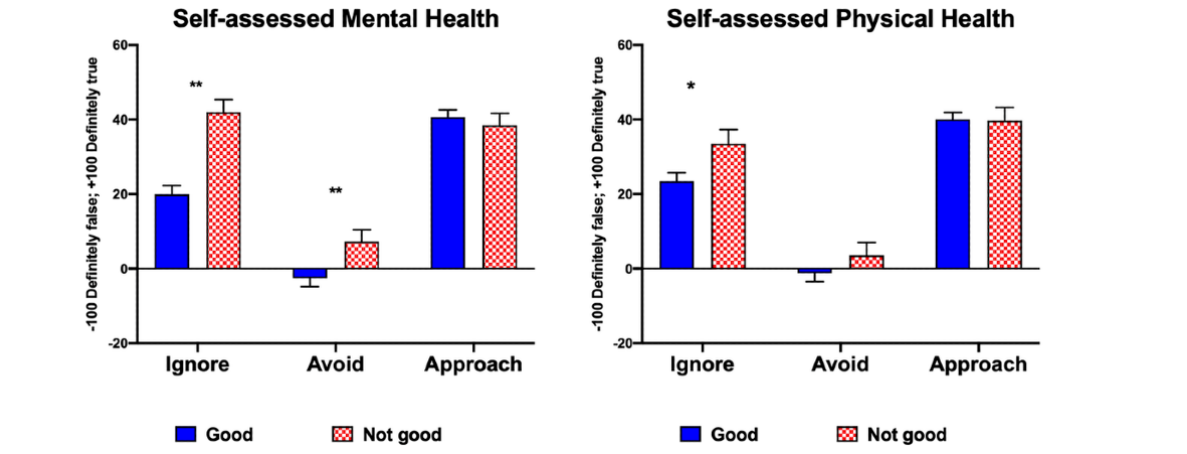
Figure 5. Physical- and mental health–related differences in appraisal (mean, standard error of the mean). Pairwise comparison of each variable independently shows significant differences related to self-assessed physical and mental health. We also found a significant likelihood that physical and mental health were related. (* P <.05; ** P